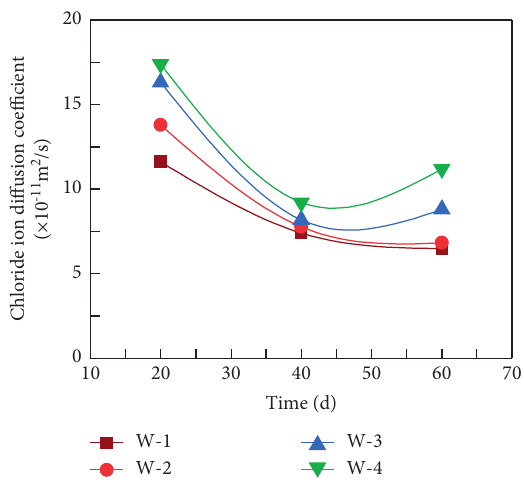
Figure 5: Chloride diffusion coefficient over